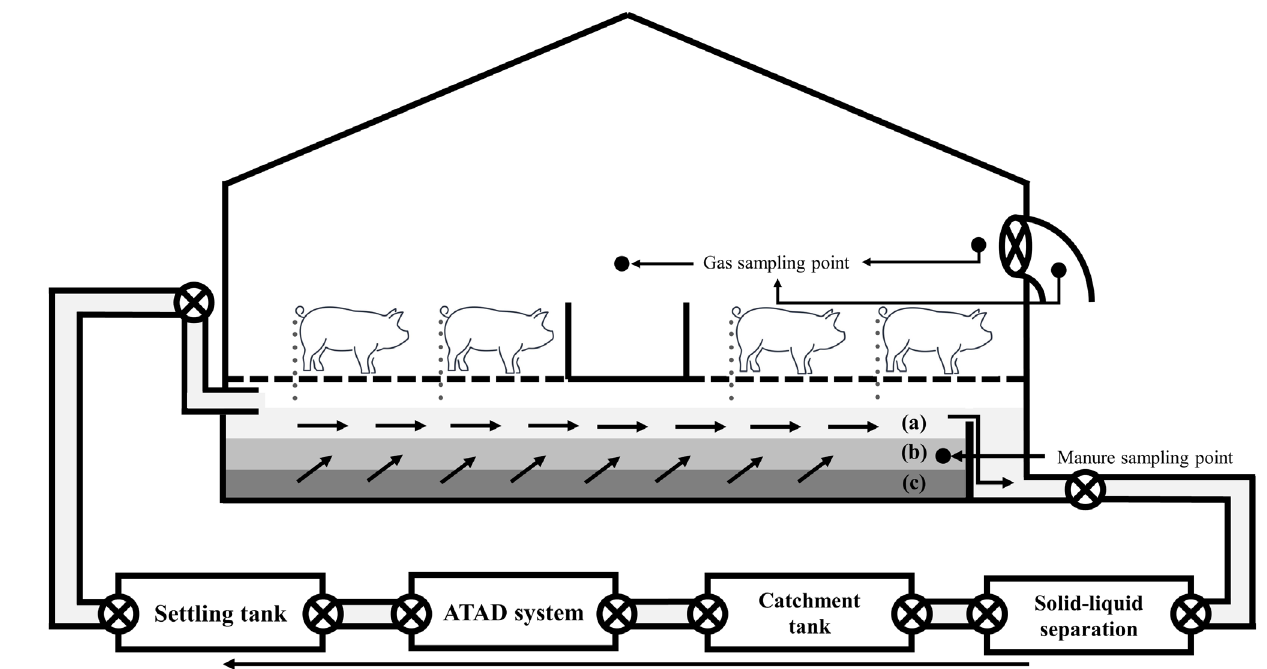
Figure 5. Schematic diagram of the experimental farm facilities with a continuous pit recirculation system (a) 40 to 60 cm; (b) 20 to 40 cm; (c) under 0 to 20 cm; (d) indoor gas sampling point; (e) exhaust fan sampling